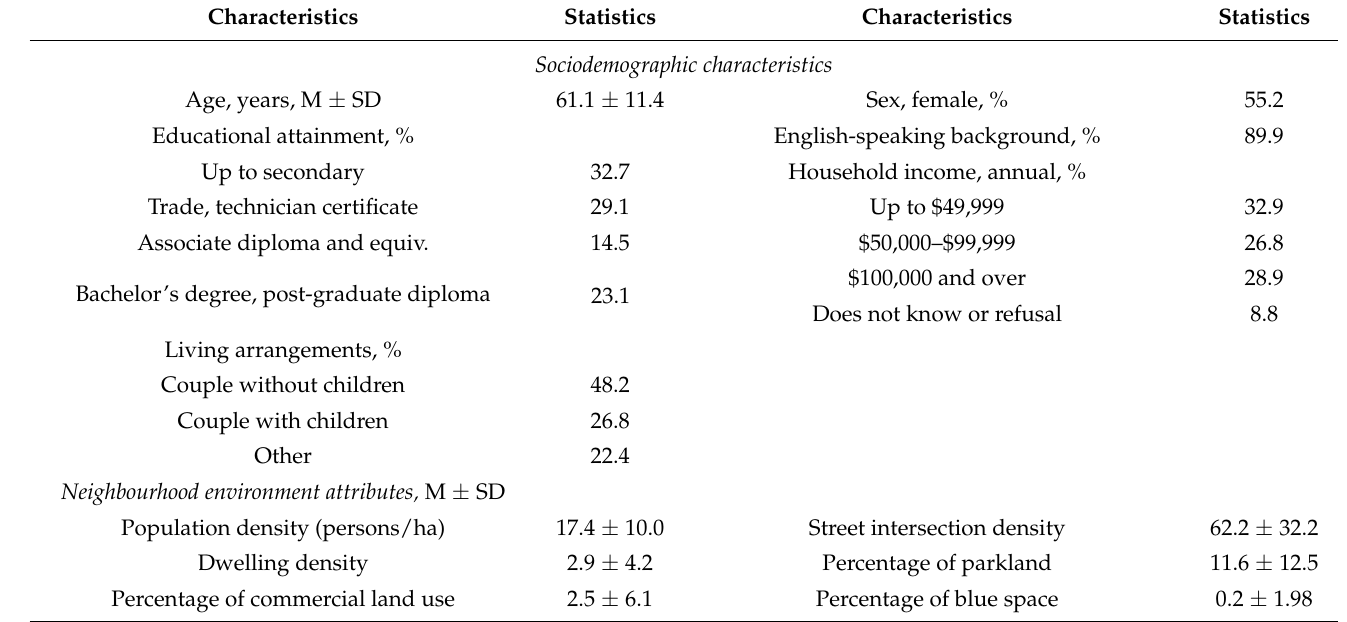
Table 1. Participant characteristics ( n =